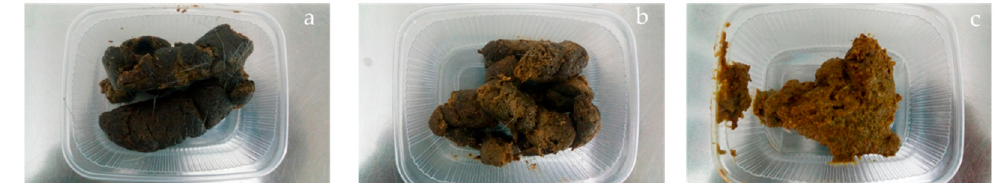
Figure 1. Fecal scores in accordance with Moxham [31] : ( a ) Score 2 (solid, well formed); ( b ) Score 3 (soft, still formed); ( c ) Score 4 (pasty, slushy); Foto: Abd El-Wahab, A. © TiHo.